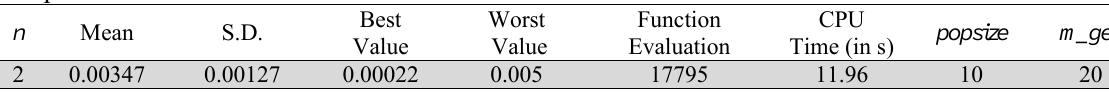
Computational Results of Problem -11